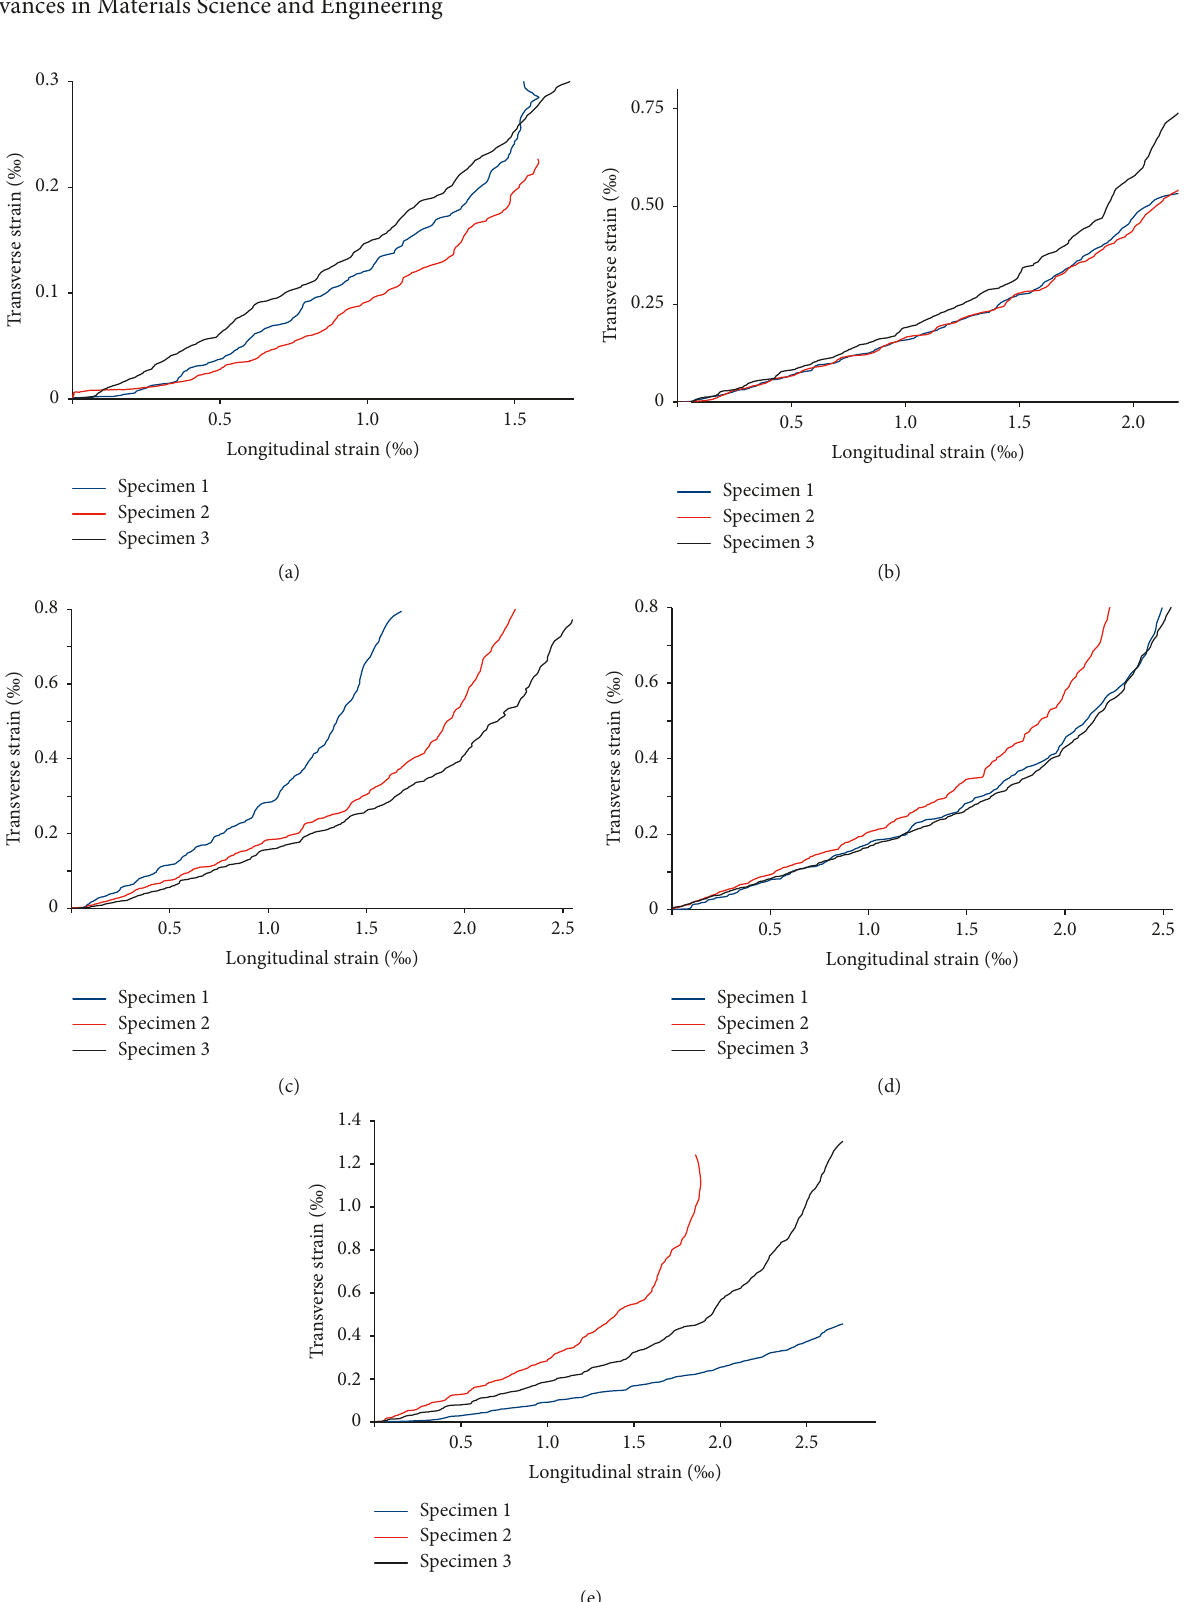
0; (b) FWR 20kg/m 3 ; (c) FWR (cid:31) (cid:31)